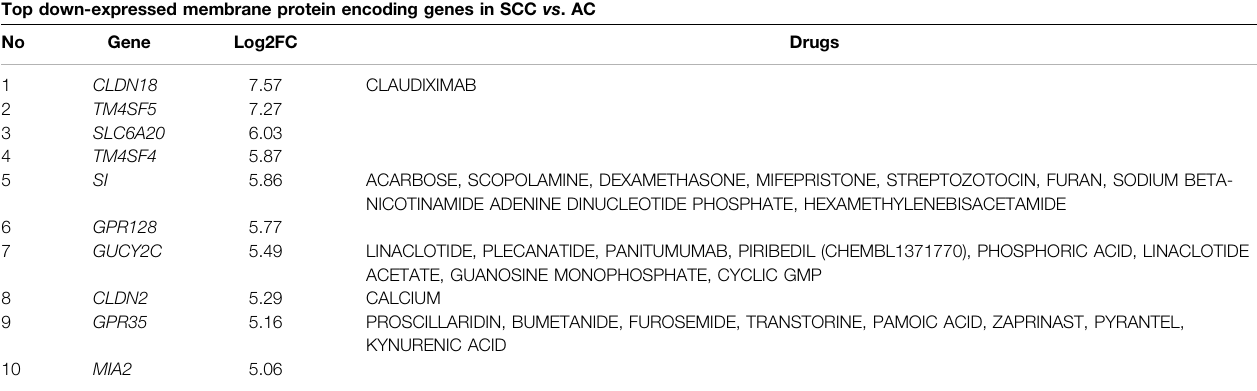
TABLE 2 | Top 10 membrane protein-encoding genes that were under- or overexpressed in SCC vs . AC Top down-expressed membrane protein encoding genes in SCC vs .